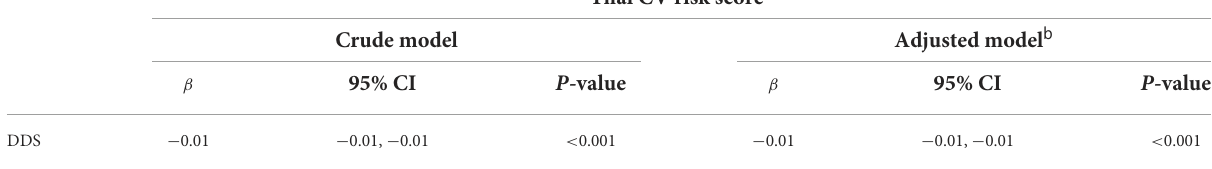
TABLE 2 Linear regression analyses for the association between each score of DDS and log-Thai CV risk score among older participants ( n = 6,662).